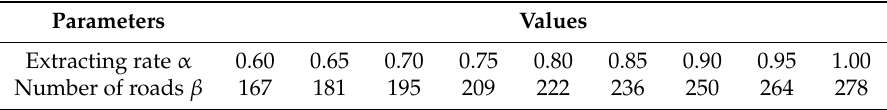
Table 1. Correspondence of extracting rate and the number of critical road